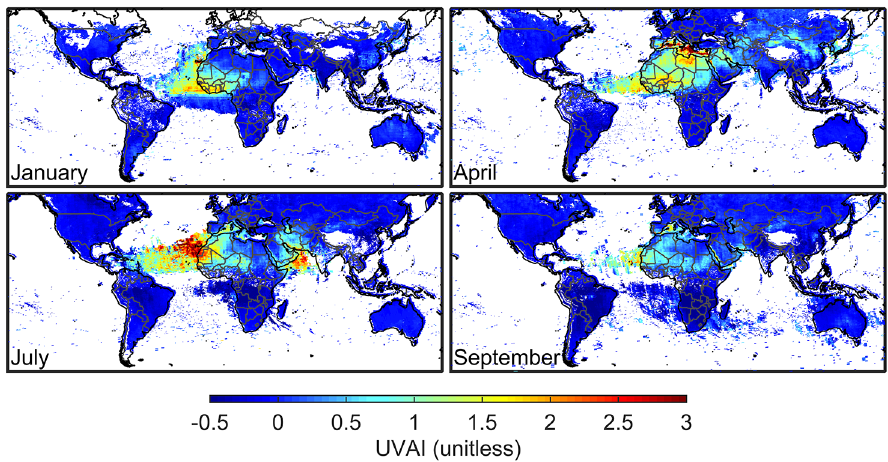
Figure 2. Monthly mean UVAI values for 2007 simulated for OMI observing conditions using the vector radiative transfer model VLIDORT coupled with GEOS-Chem aerosol fields for the base case without brown carbon (BrC). White indicates cloud or snow contamination.